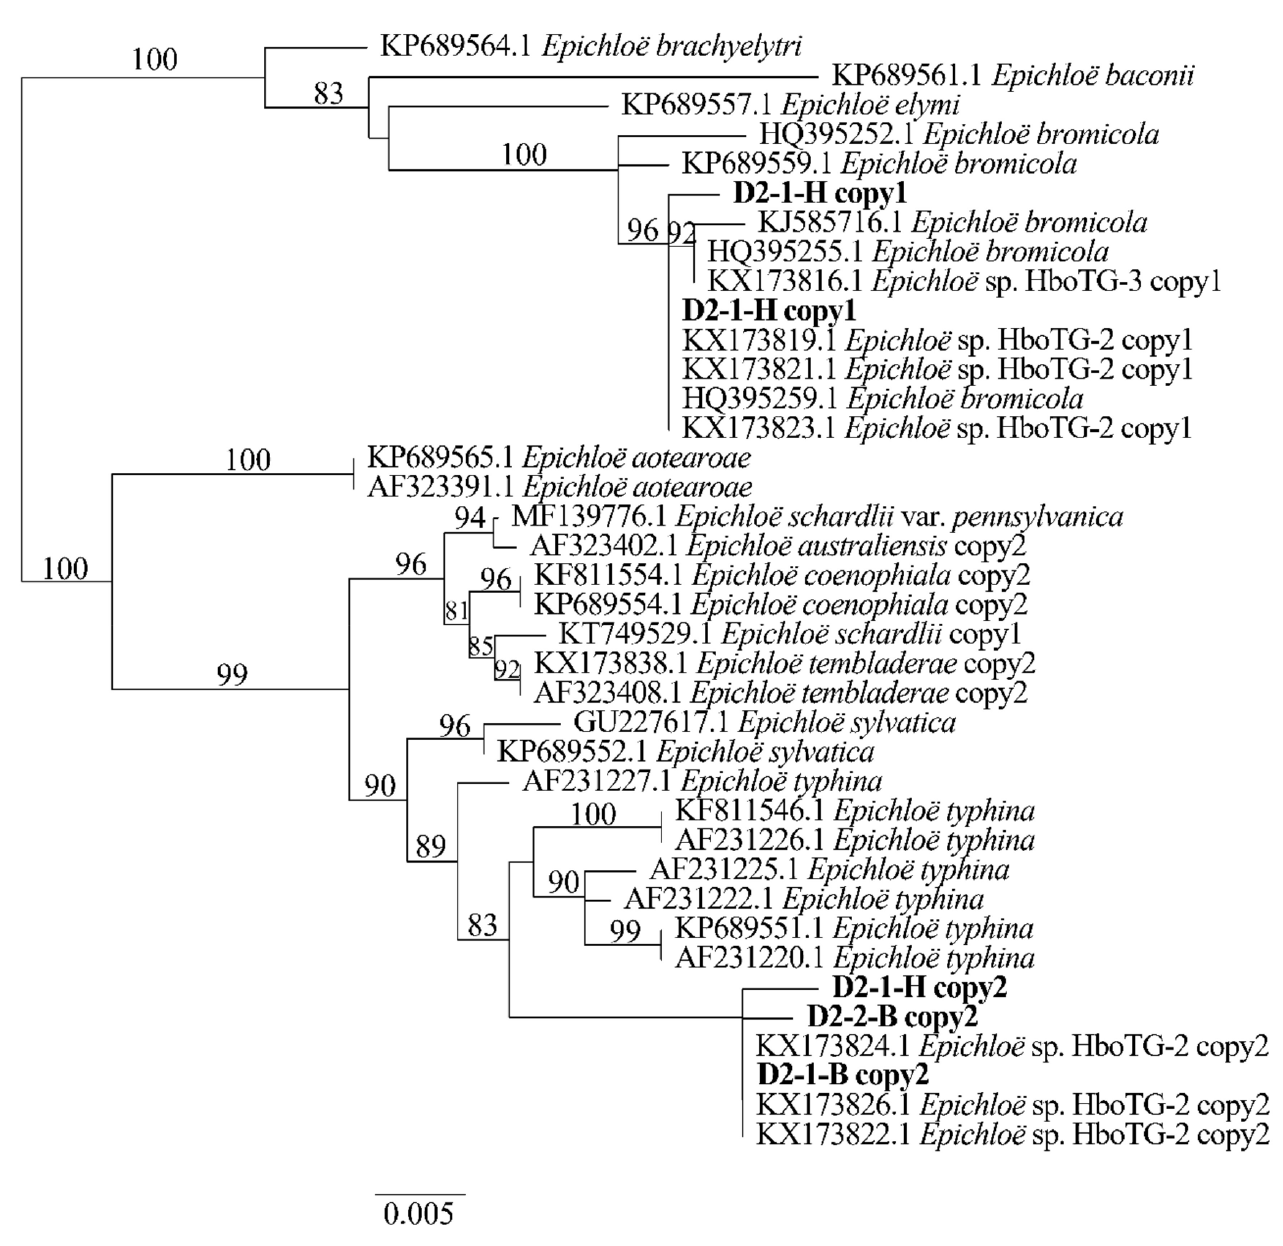
Figure 2. Molecular phylogeny derived from maximum likelihood (substitution model TIM3e + G4) analysis of the tefA gene from representative Epichloë species and copies of the hybridized endophytes isolated from H. bogdanii